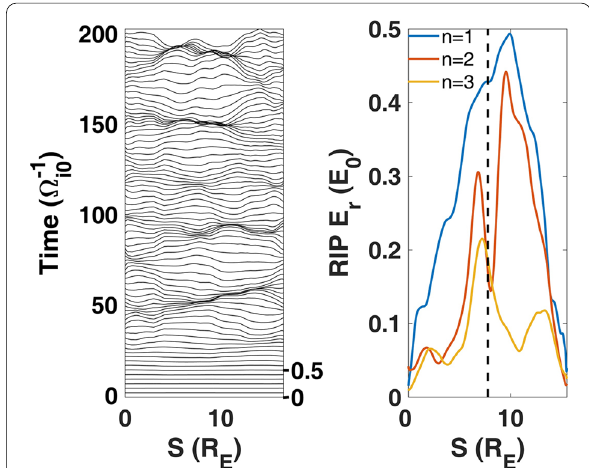
Fig. 6 Dominant harmonic eigenstructures of E r along the closed 8 R E . a The dominant field line in the noon-meridian plane at L = 0 200 (cid:31) − 1 i 0 fundamental harmonic oscillations of E r between t = − in time sequence. b The RIPs of the fundamental, second and third harmonic mode structures of E r along the dipole-like field line in 8 R E . The vertical dashed line marks the noon-meridian plane at L = the equator position. The relative magnitude of oscillations for the fundamental harmonic is also marked at the right bottom in